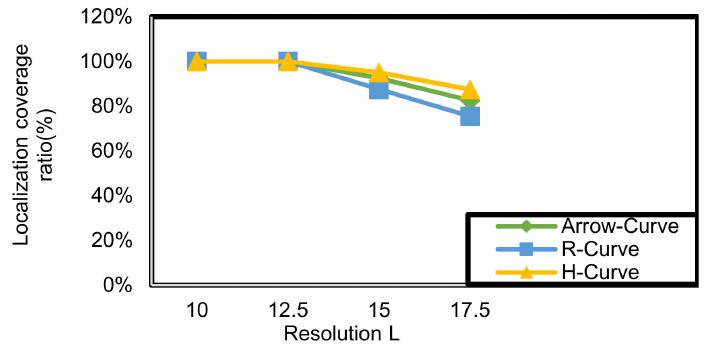
Figure 14. Localization coverage ratio corresponding to resolution (L) in Arrow-Curve path model, R-Curve path model, and H-Curve.